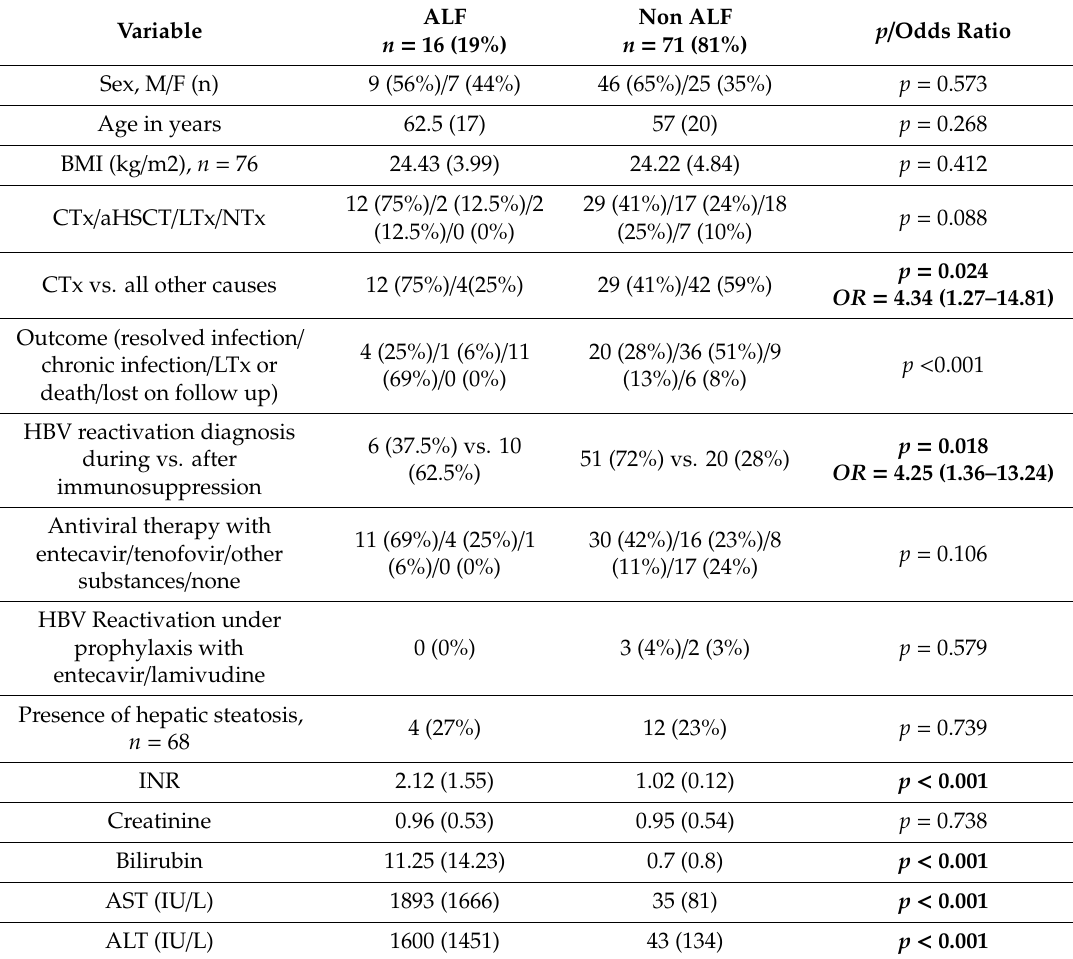
Table 1. Clinical and laboratory parameters of patients with hepatitis A virus (HBV) reactivation at the time of HBV reactivation diagnosis stratified according to their liver function: acute liver failure (ALF) vs. non-ALF